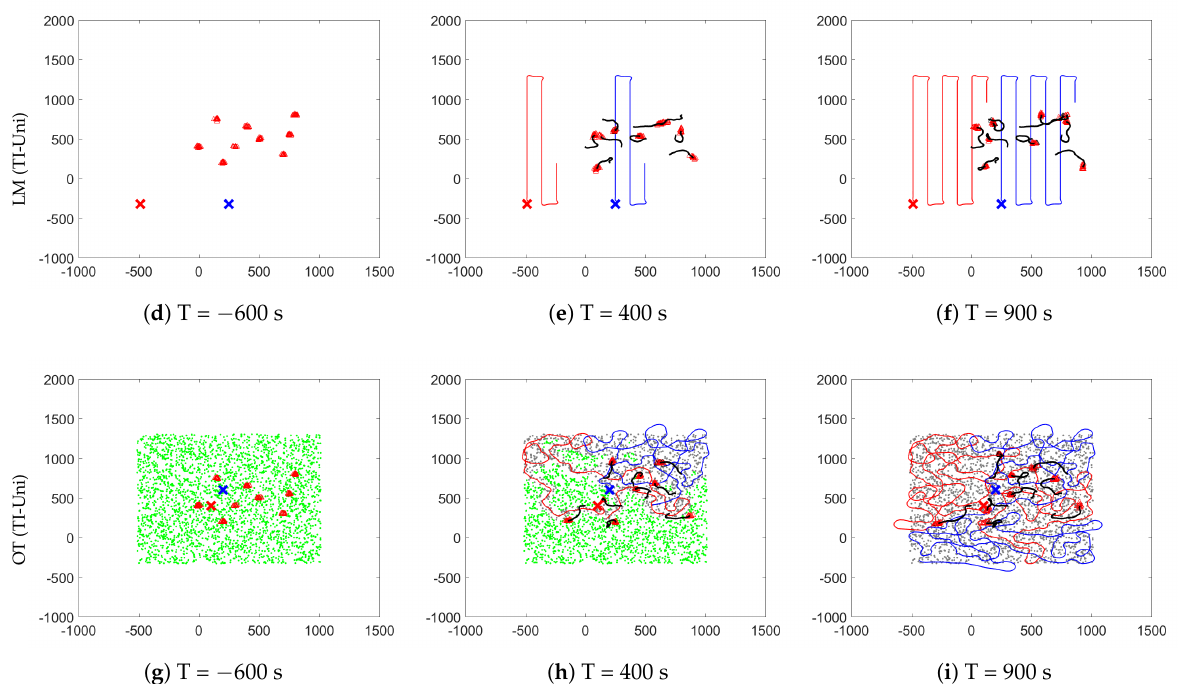
Figure 6. Snapshots of different monitoring strategies for the 2-agent case: ( a – c ) OT (TV-Gauss); ( d – f ) LM (TI-Uni); ( g – i ) OT (TI-Uni). The negative time indicates the time to travel from the base station to the pre-specified location before the initiation of the monitoring mission. The monitoring mission starts at T = 1 s and continues until 900